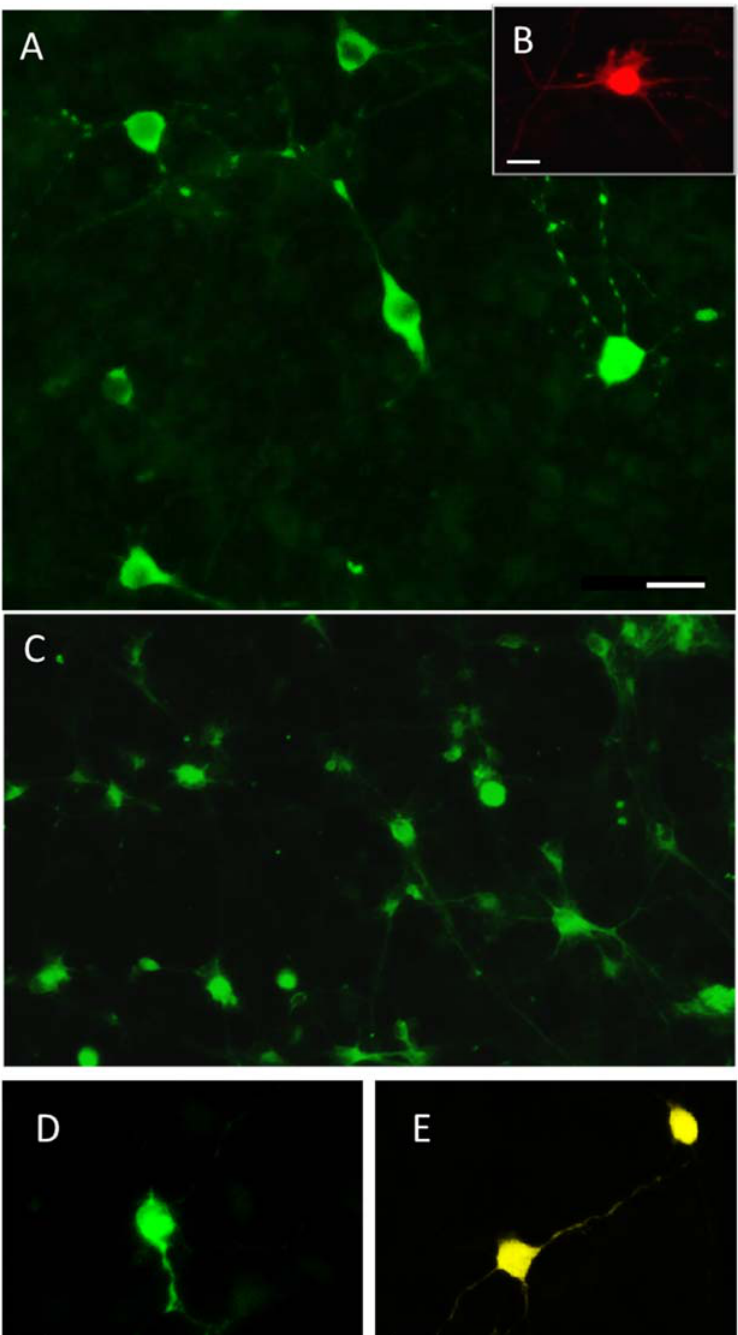
Figure 2. Primary mouse mesencephalon culture containing numerous tyrosine hydroxylase-immunopositive neurons ( A ) and rare 5-hydroxytryptamine-immunopositive neurons ( B ), as well as a primary mouse metencephalon culture containing numerous dopamine- β -hydroxylase-immunopositive neurons ( C ), as well as rare dopamine transporter-immunopositive neurons ( D ) and 5-hydroxytryptamine-immunopositive neurons ( E ). Objective magnification = × 20 (Plan-Neufluar). Bars = 25 µ m for ( A , C , E ); 15 µ m for ( B ); 10 µ m for ( D ). After culturing mouse embryonic metencephalon for one week, numerous dopamine- β -hydroxylase(DBH)-immunopositive neurons and rare 5-HT-immunopositive neurons were found (Figure 2C). Although DAT immunopositive neurons were also detected in this culture (Figure 2D,E), their numbers were extremely low (two cells in all